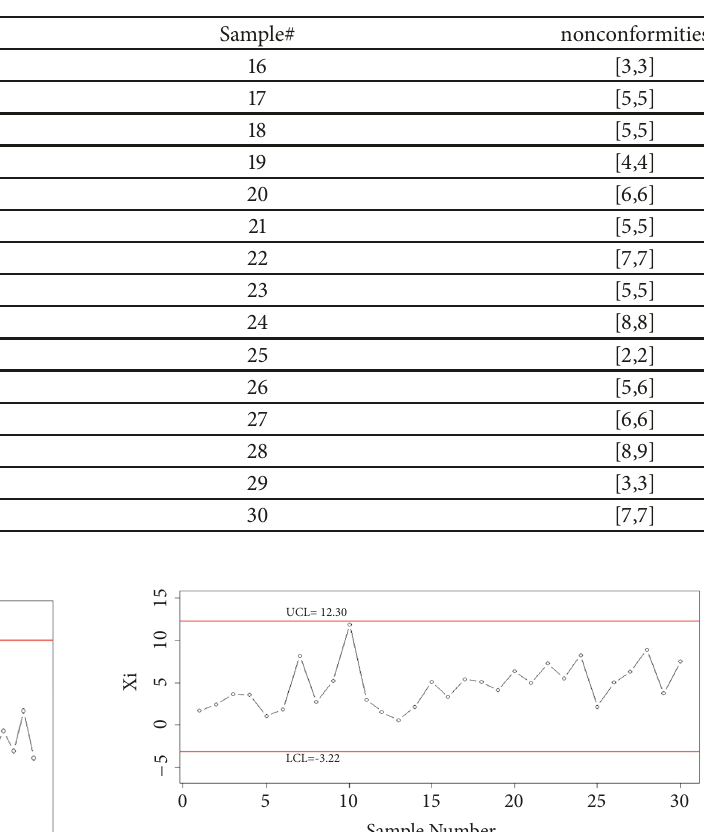
Table 5: Number of nonconformities in 100 samples.